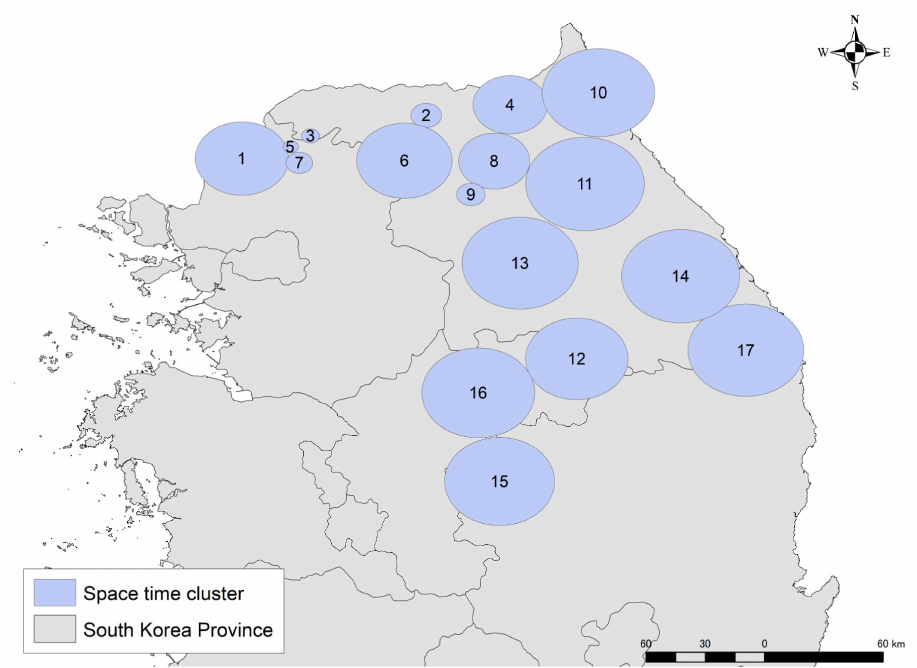
Figure 2. Locations of the significant space-time clusters of African swine fever (ASF) cases in wild boar. The spatio-temporal clusters are depicted by light blue circles, and the clusters are ordered